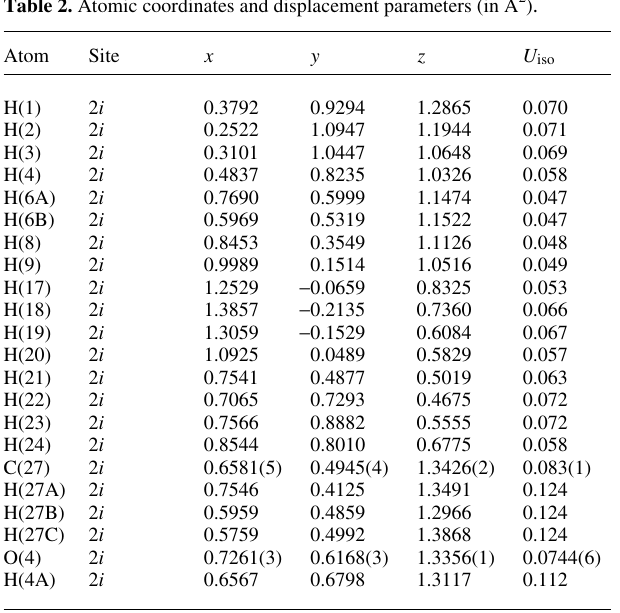
Table 2. Atomic coordinates and displacement parameters (in Å 2 )